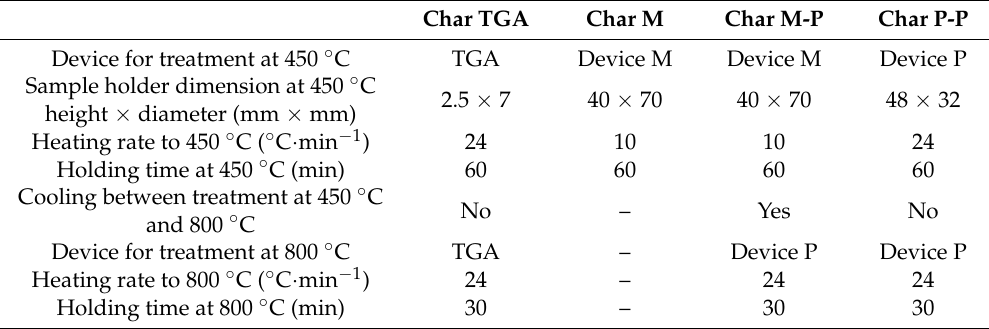
Table 2. Pyrolysis conditions for char preparation from the biomass samples. Char TGA Char